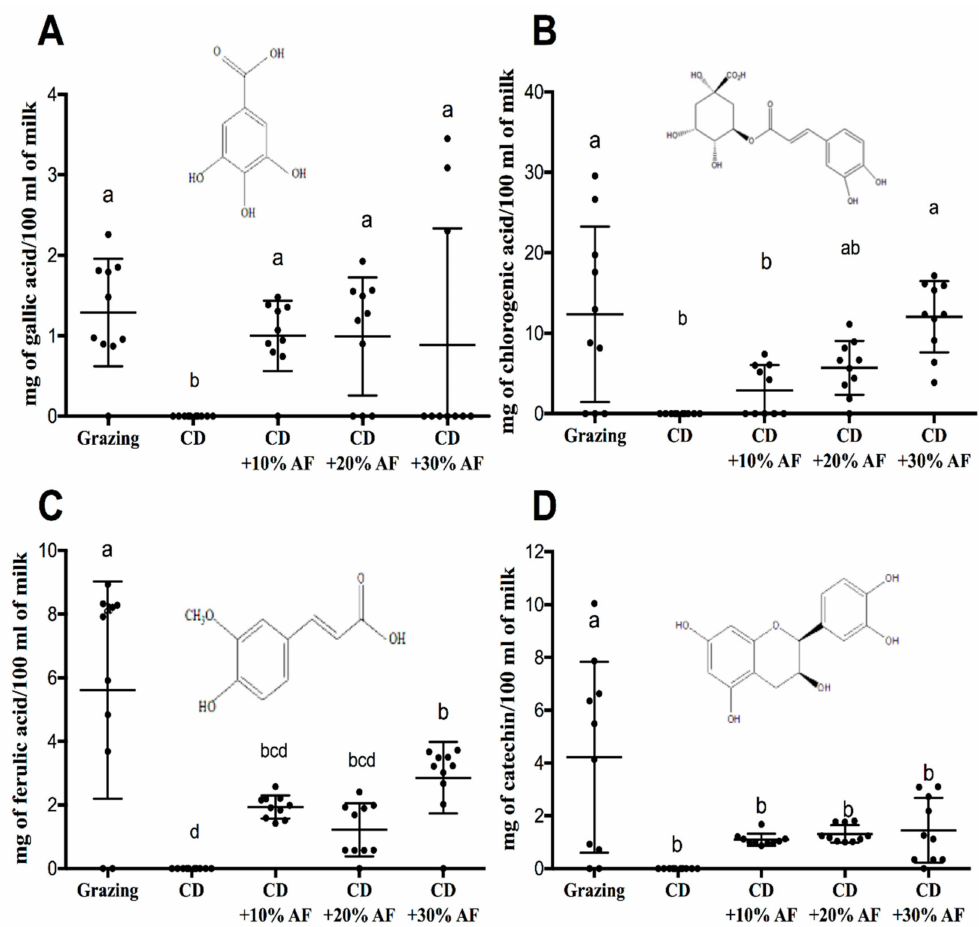
Figure 2. Bioactive compounds ( A – D ) in milk from goats fed conventional diet versus diets supplemented with graded levels of Acacia farnesiana pods (AF) by HPLC. CD = Conventional diet. a,b,c,d Means with di ff erent letters indicate di ff erences ( p < 0.05) among